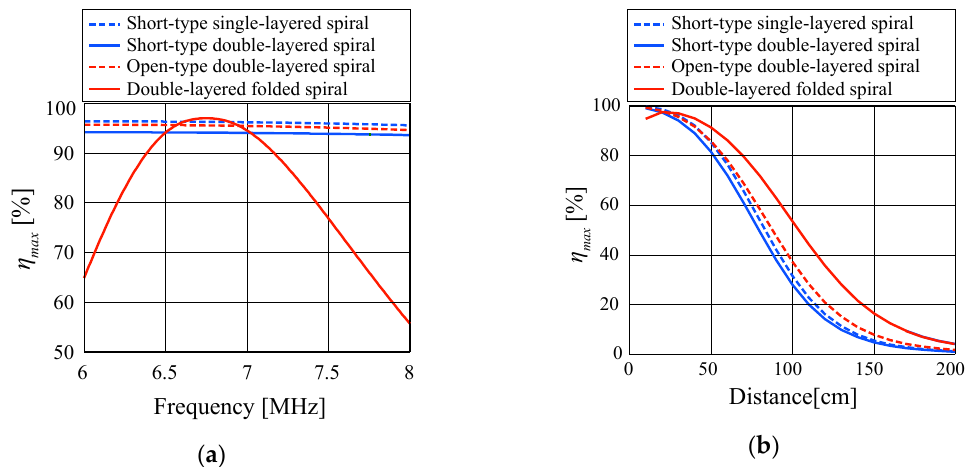
Figure 12. Characteristics of η _max . ( a ) Frequency characteristics and ( b ) transfer distance characteristics.